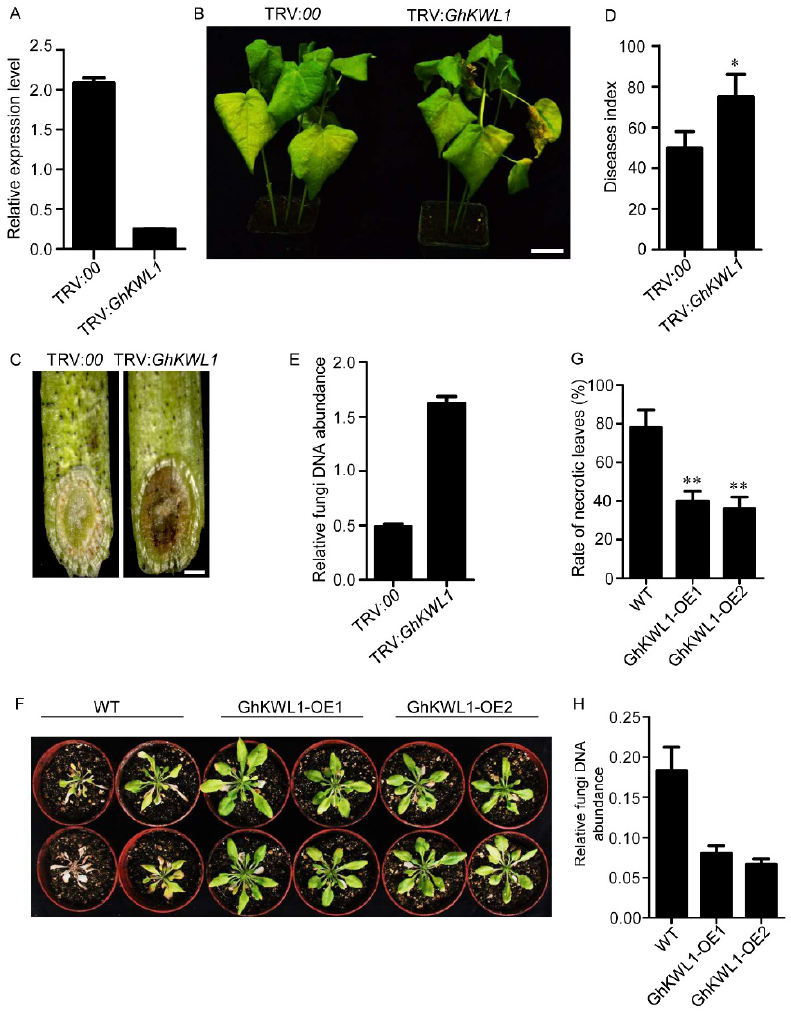
Figure 2. The downregulation of GhKWL1 enhances the susceptibility of cotton to V. dahliae infection, and the overexpression of GhKWL1 enhances the resistance of Arabidopsis to V. dahliae infection. ( A ) The expression level of GhKWL1 in leaves of GhKWL1 -silenced (TRV: GhKWL1 ) plants and the parallel control (TRV: 00 ). Total RNAs were extracted from leaves of cotton plants after 2 weeks of virus-induced gene silencing of GhKWL1 . ( B ) Disease symptoms of TRV: 00 and TRV: GhKWL1 cotton plants infected with V. dahliae . Seedlings after 2 weeks of virus-induced gene silencing of GhKWL1 were inoculated with 10 mL V. dahliae conidial suspension (10 7 conidia/mL) for 20 d. The scale bar represents 3 cm. ( C ) Sections of TRV: 00 and TRV: GhKWL1 cotton stems at 20 d post-inoculation (dpi). The brown areas are diseased vascular bundles. The scale bar represents 1 mm. ( D ) Disease index of TRV: 00 and TRV: GhKWL1 cotton plants at 20 dpi. Three independent replicates were performed, with at least 20 plants being measured per VIGS event and replicate. Asterisks indicate statistical significance as determined by Student’s t -test (* p < 0.05). ( E ) Fungal DNA abundance in leaves of TRV: 00 and TRV: GhKWL1 cotton plants. The DNA was isolated from upland cotton leaves at 20 dpi. ( F ) Disease symptoms of Arabidopsis infected with V. dahliae . Three-week-old Arabidopsis plants were inoculated with V. dahliae for 25 d. Three independent replicates were performed, with at least 20 plants being measured per transgenic event and replicate. ( G ) Percentage of necrotic leaves in the Arabidopsis plants at 25 dpi. Asterisks indicate statistical significance as determined by Student’s t -test (** p < 0.01). ( H ) Fungal DNA abundance in leaves of the Arabidopsis plants. The DNA was isolated from Arabidopsis leaves at 25 dpi. The relative level was determined by quantitative RT-PCR ( A , E , H ). GhUBQ7 served as the reference gene in cotton ( A , E ); AtACTIN2 served as the reference gene in Arabidopsis ( H